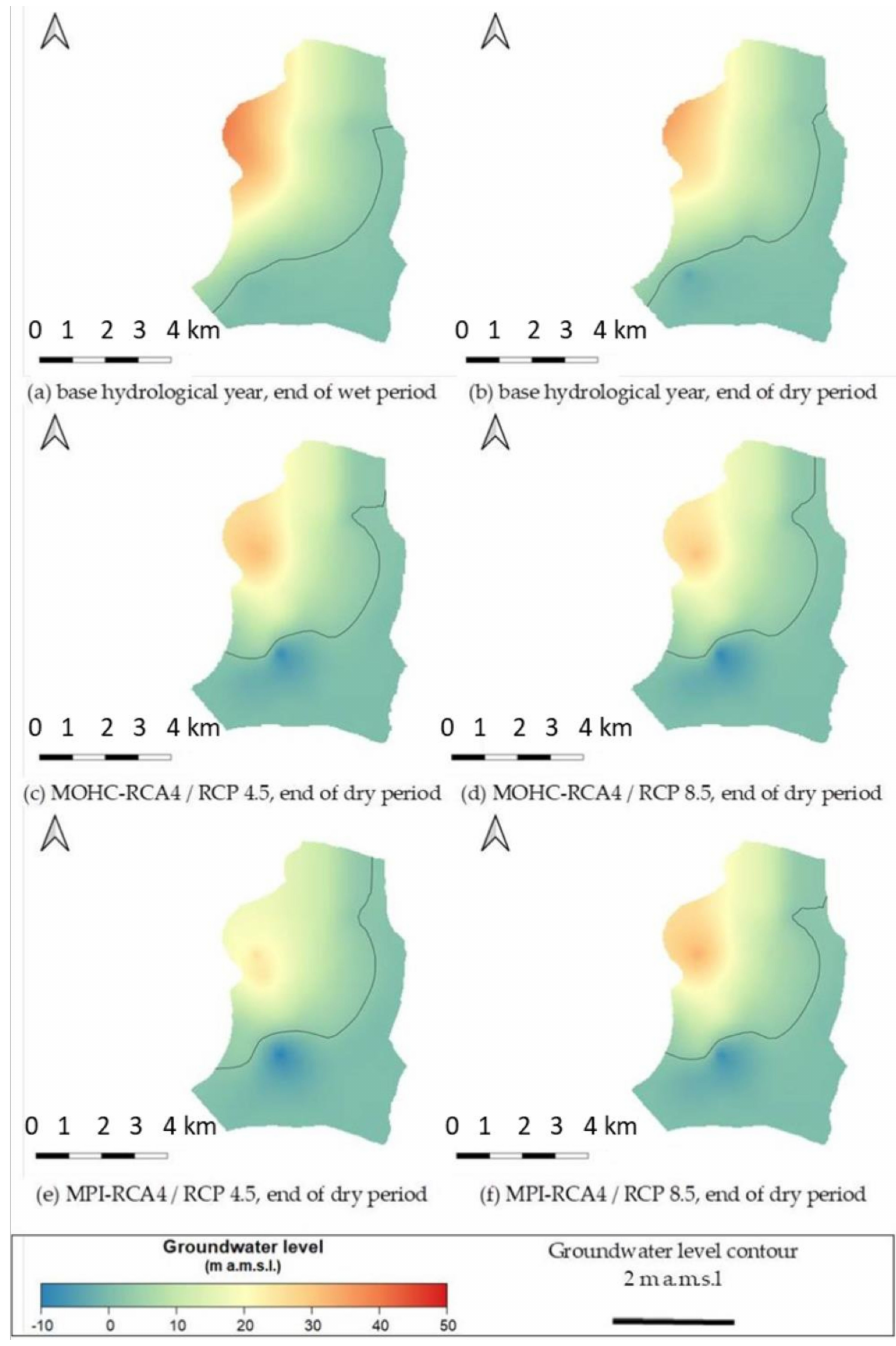
Figure 2. Groundwater level in Kiti aquifer—Results of numerical